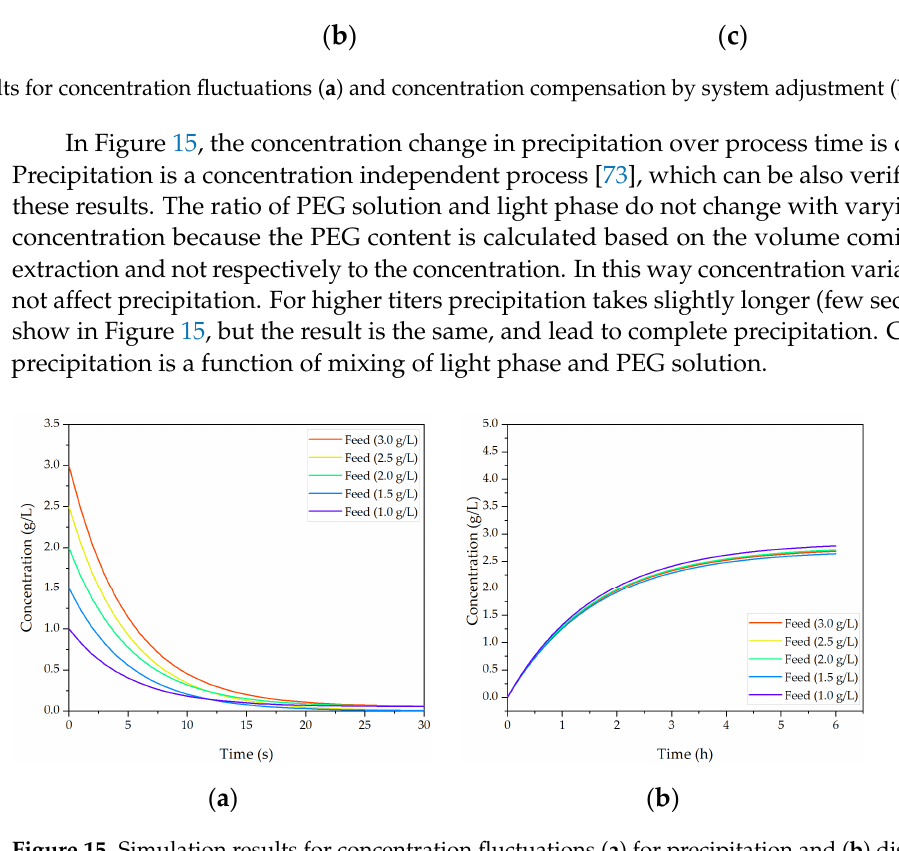
Figure 15. Simulation results for concentration fluctuations ( a ) for precipitation and ( b )